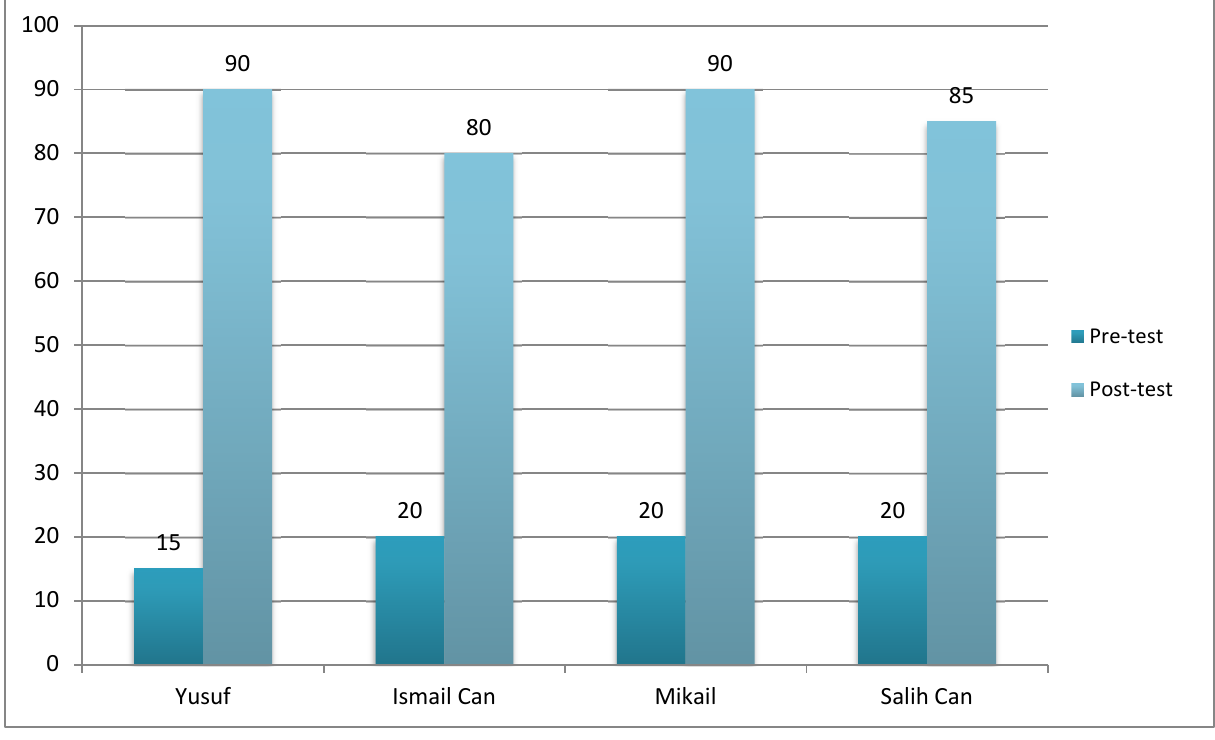
Figure 4. Basic basketball skills generalization data.